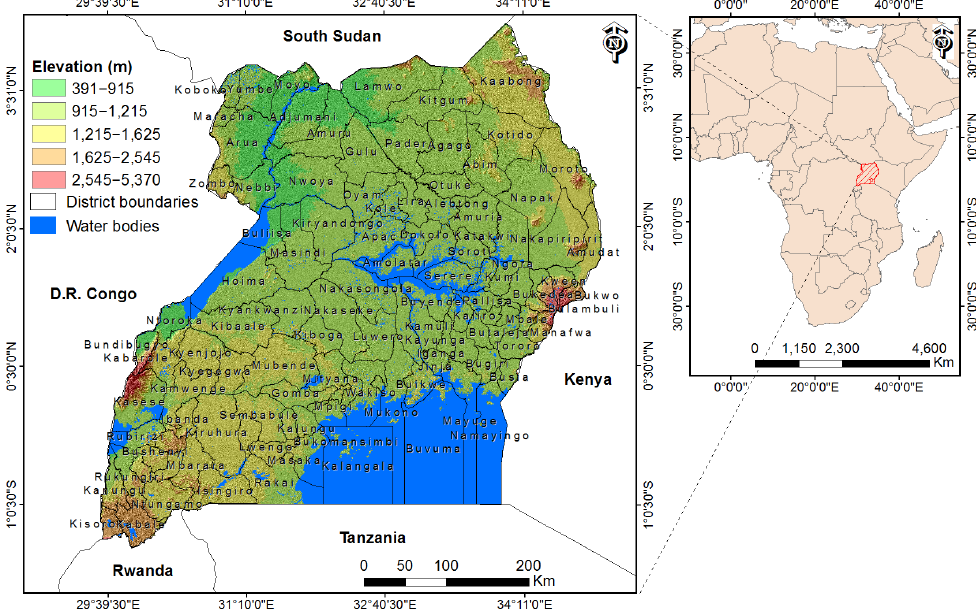
Figure 1. Map showing the elevation and district administrative boundaries of Uganda.